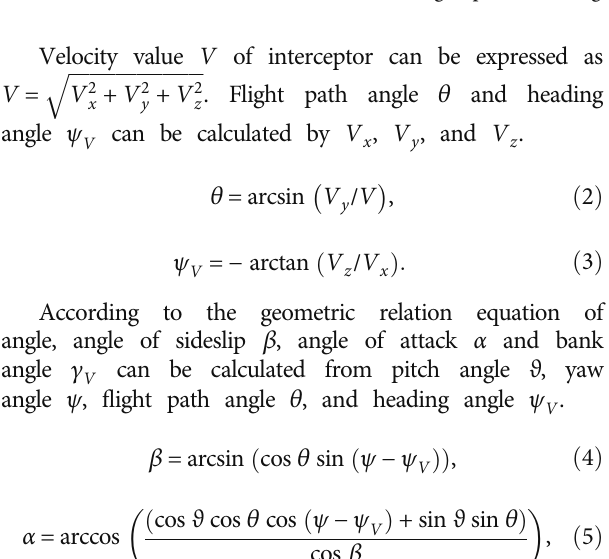
Figure 1: High-speed and long-range interceptor trajectory